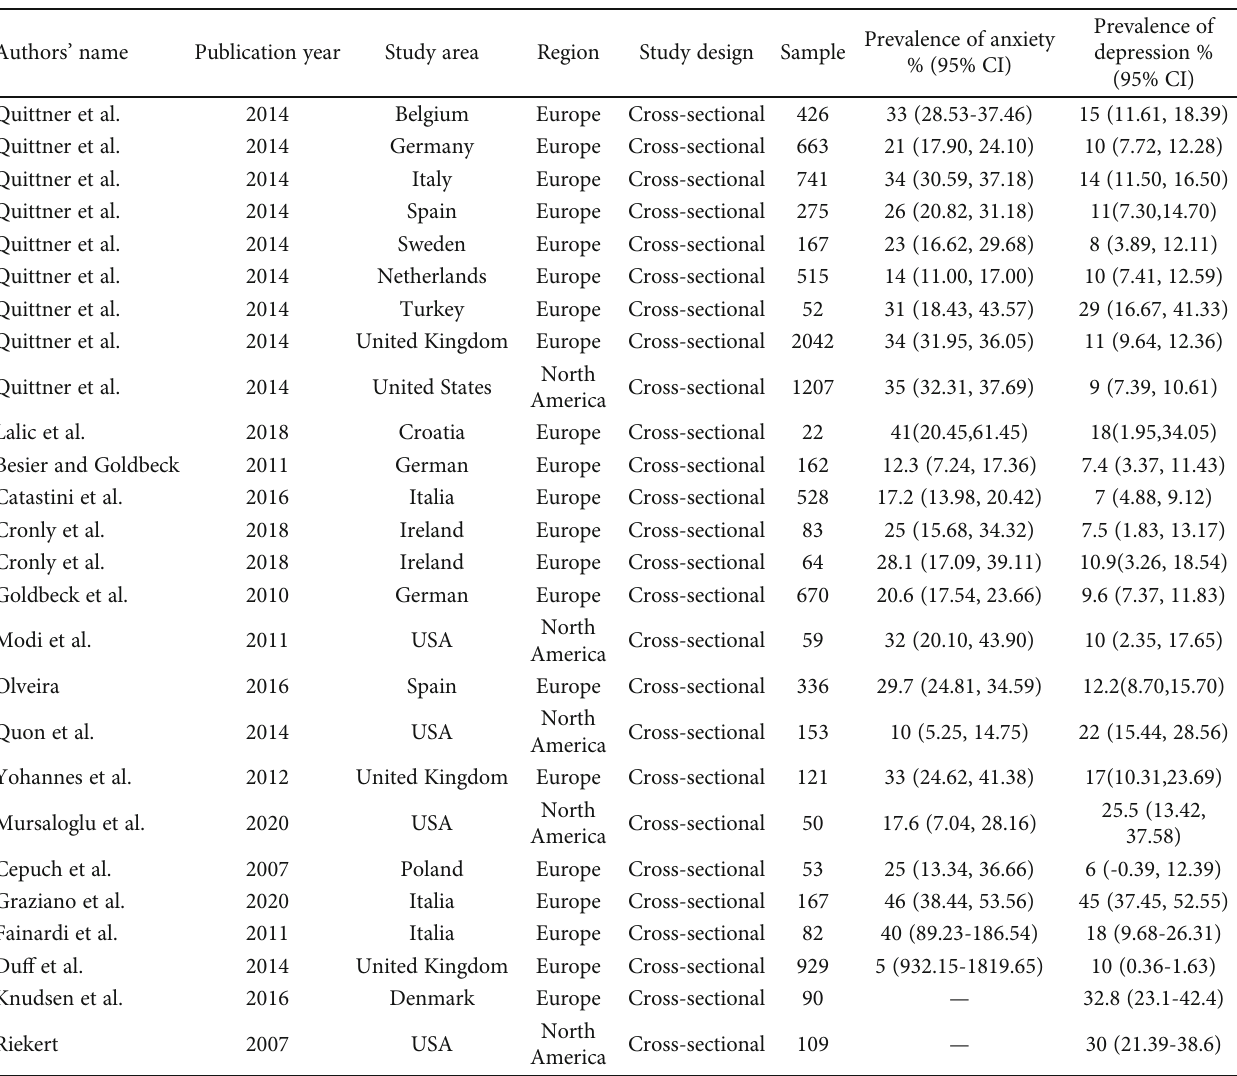
Table 1: Characteristics of the included studies of anxiety in the systematic review and